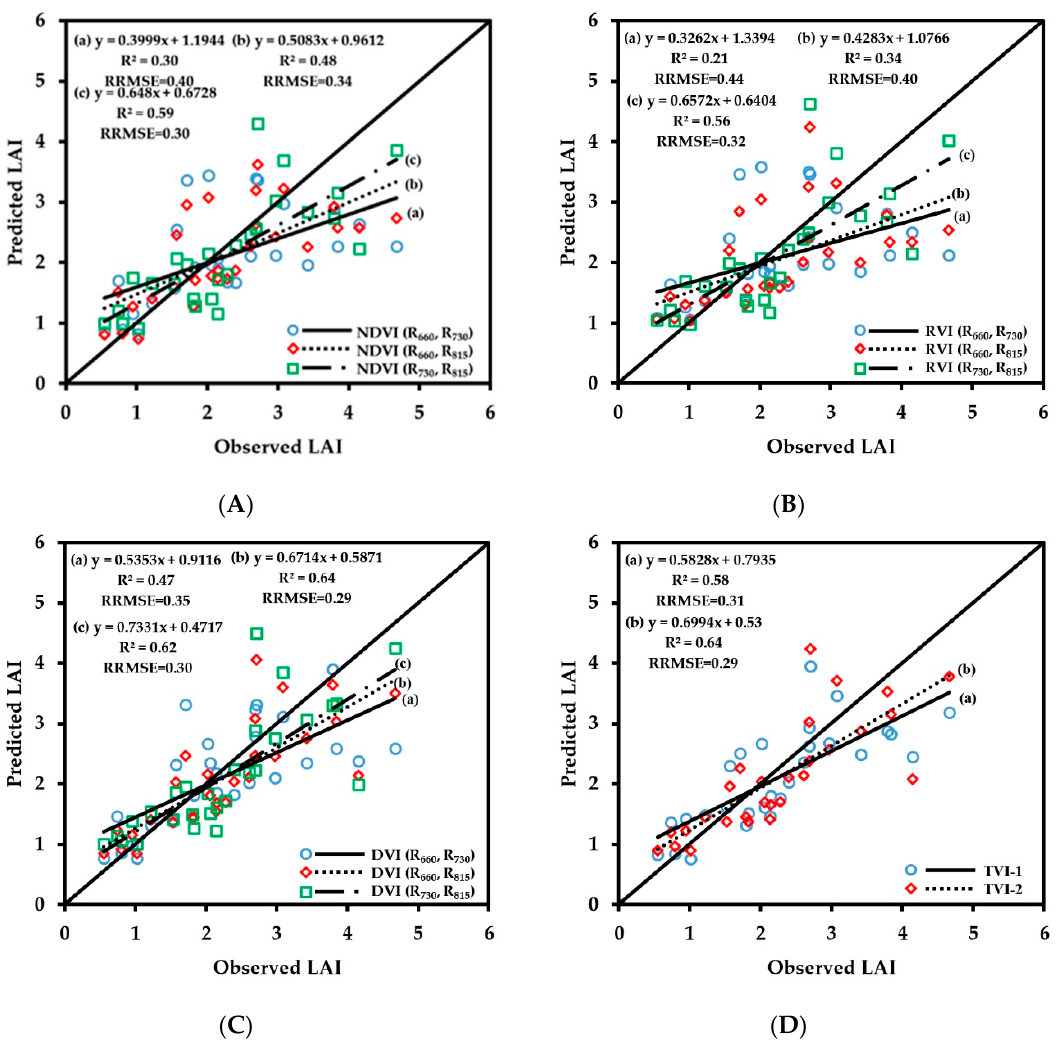
Figure 7. The relationships between observed and predicted LAI values of wheat varieties based on NDVI ( A ), RVI ( B ), DVI ( C ) and TVI ( D ) models.